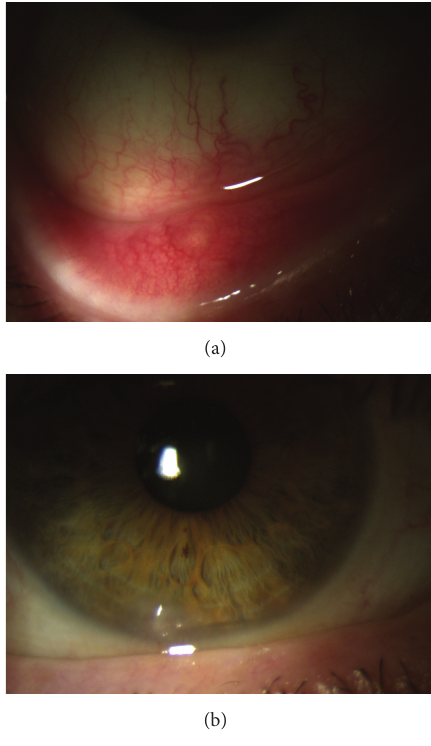
Figure 5: Right eye after therapy.